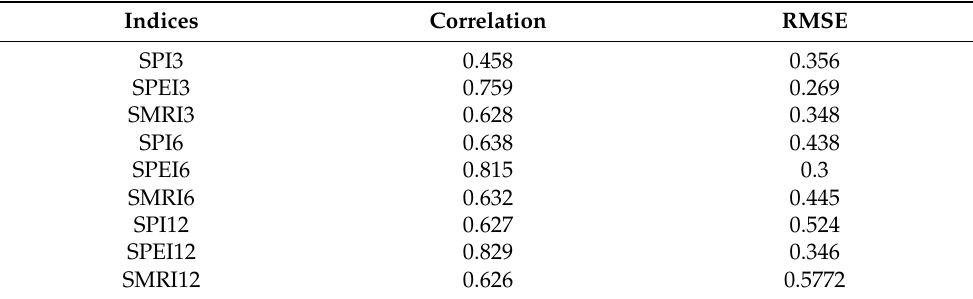
Table 5. Correlation and RMSE of ERA5 against observational indices over Urmia Lake basin. Indices